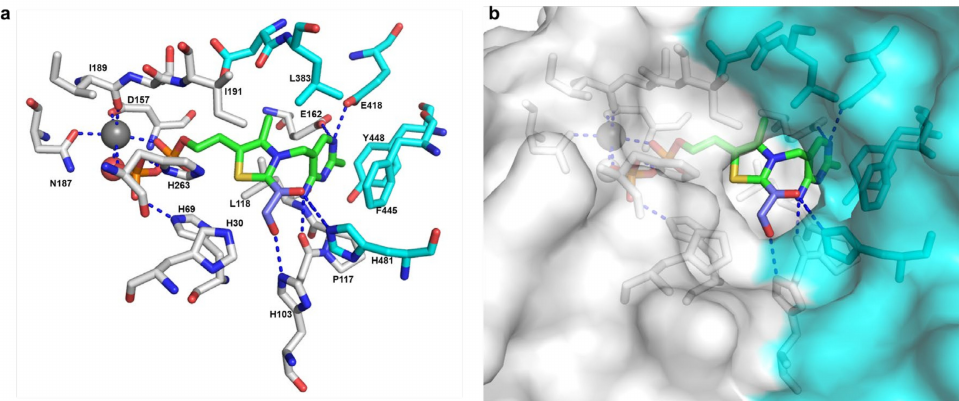
Figure 1. ( a ) Interactions between the Thiamine diphosphate (ThDP) cofactor (green) and residues from both monomers (white / cyan) in Saccharomyces cerevisiae transketolase ( Sc TK). The covalent C 2 -ketol intermediate is stabilised by hydrogen bonds with two histidine residues. ( b ) Surface view of the active site in WT Sc TK. The ThDP cofactor is buried within the enzyme, and only accessible via a narrow substrate channel. This sterically limits the size of the donor substrate to the transfer of a C 2 -ketol unit in WT Sc TK. Figures were created in PyMol from 1gpu.pdb. Dotted lines denote H-bonds or ionic